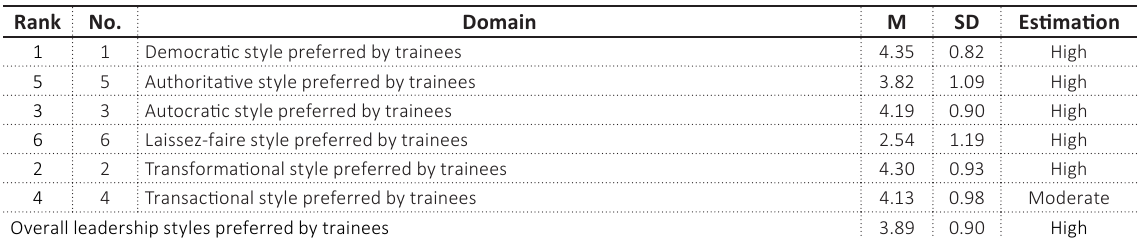
Table 4. Means and standard deviations of respondents’ estimates of leadership styles in descending order of means